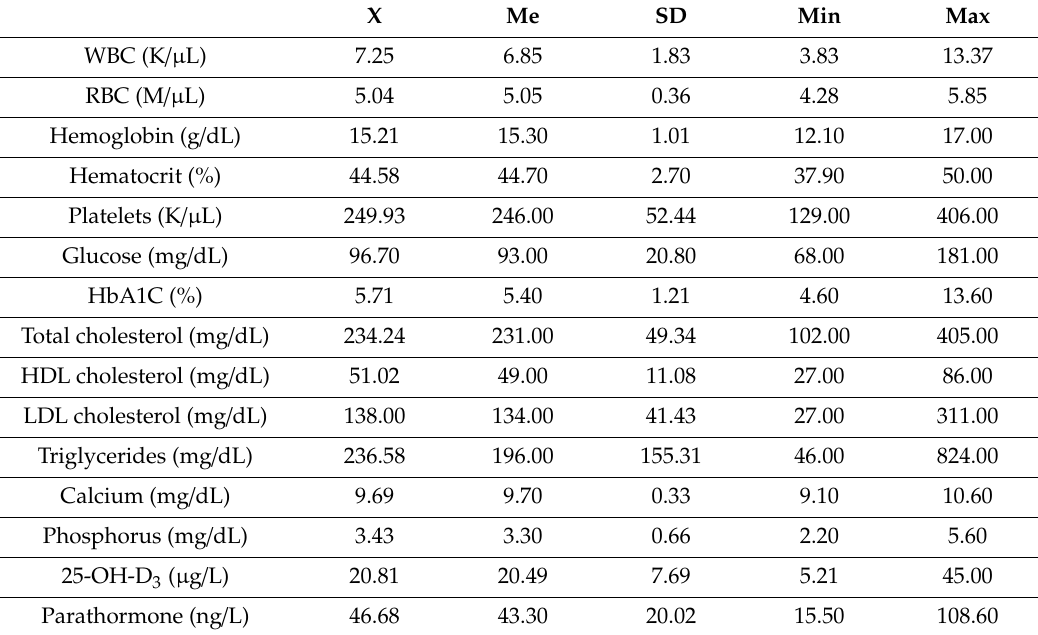
Table 2. Conventional lab tests and calcium-phosphate balance in the study